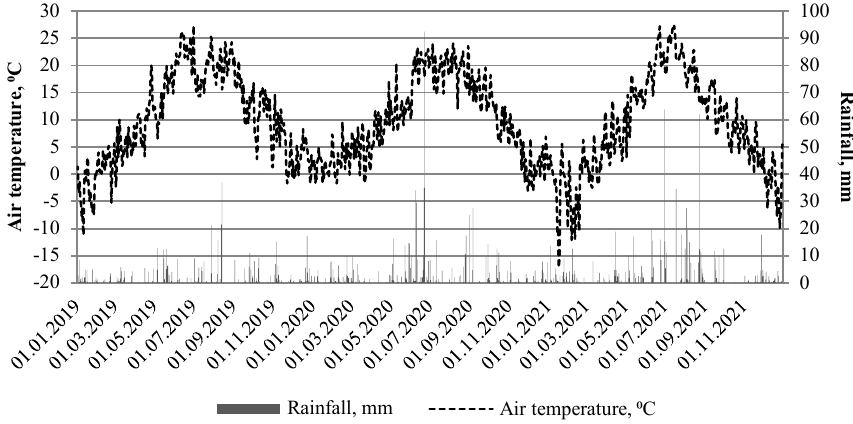
Fig. 9. Dynamics of monthly average air temperature and rainfall within BR